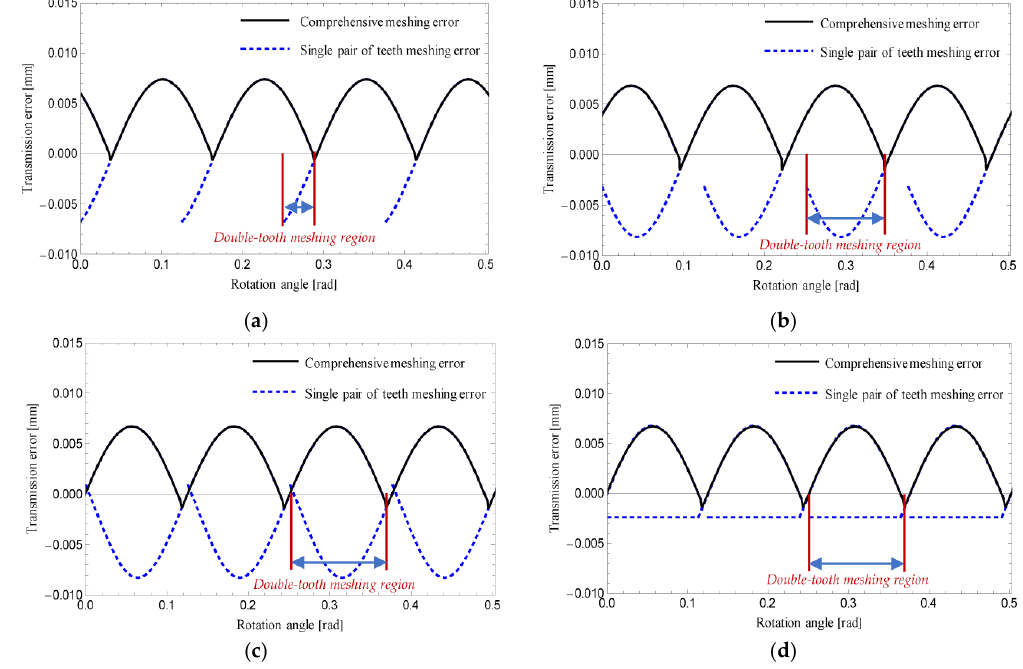
Figure 5. The single pair of teeth meshing error and comprehensive meshing error with different contact ratio: ( a ) 𝜀 = 1.28 ; ( b ) 𝜀 = 1.75 ; ( c ) 𝜀 = 1.92 ; ( d ) 𝜀 = 1.92 (adjusted profile devia- tion) .